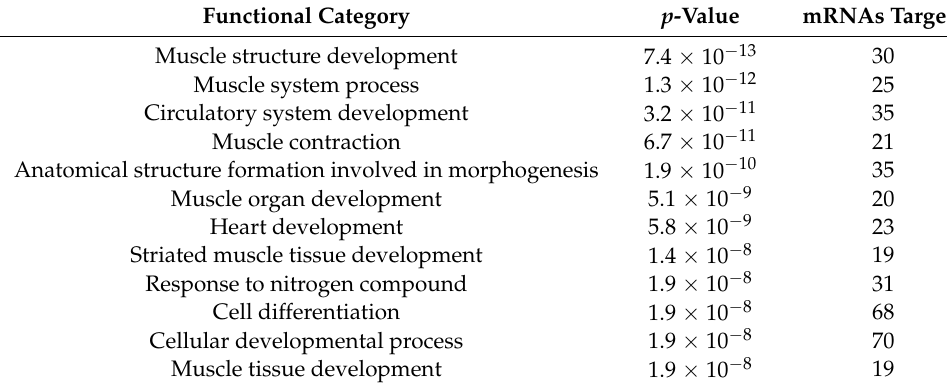
Table 2. Top functional enrichments among predicted targets of miRNAs differentially expressed during control human myoblast differentiation but not in CMD